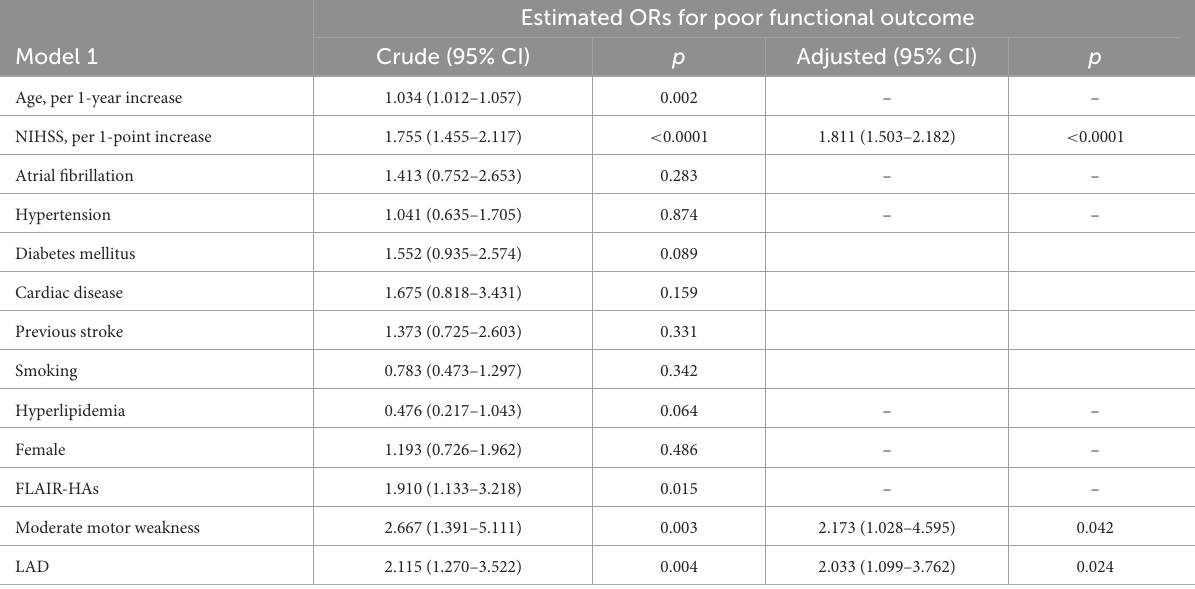
TABLE 4 Multivariate analysis of prediction for poor functional